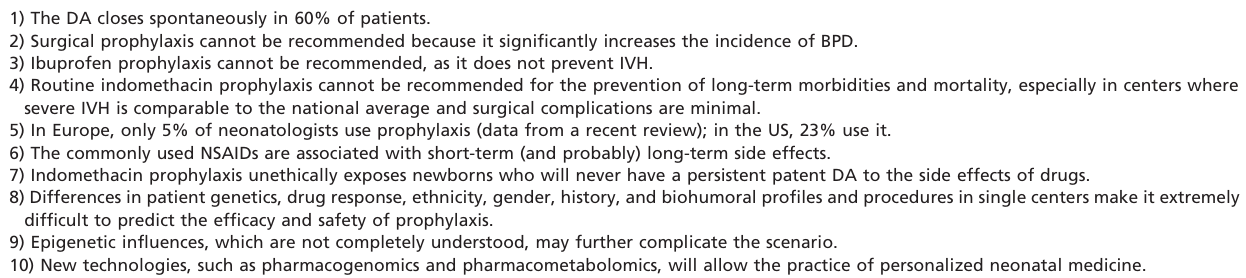
Table 1 - Ten reasons to definitively abandon PDA